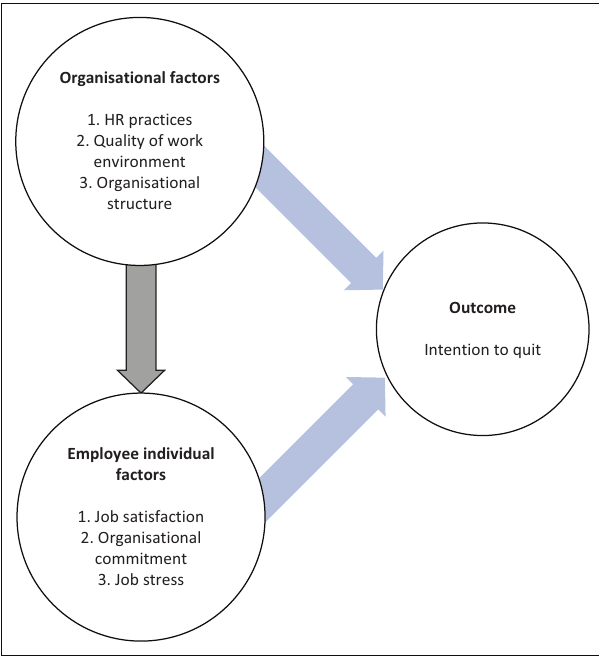
FIGURE 1: Conceptual framework of selected individual and organisational factors influencing intention to quit.